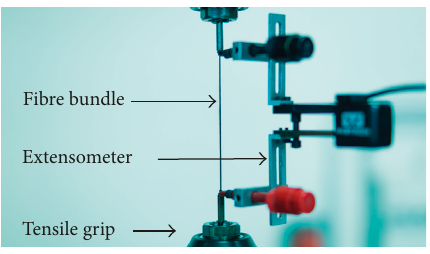
Figure 2: Bundle tensile test